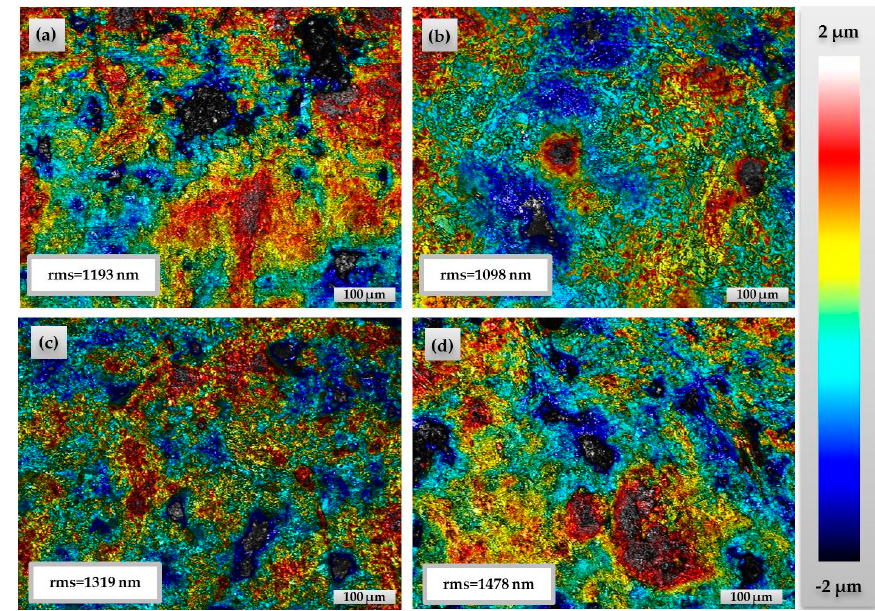
Figure 9. Confocal microscopy images of BPP ( a ) after aging, and after potentiostatic measurements at ( b ) OCP, ( c ) 0.1 V, and ( d ) 0.8 V. ( b ) OCP, ( c ) 0.1 V, and ( d ) 0.8